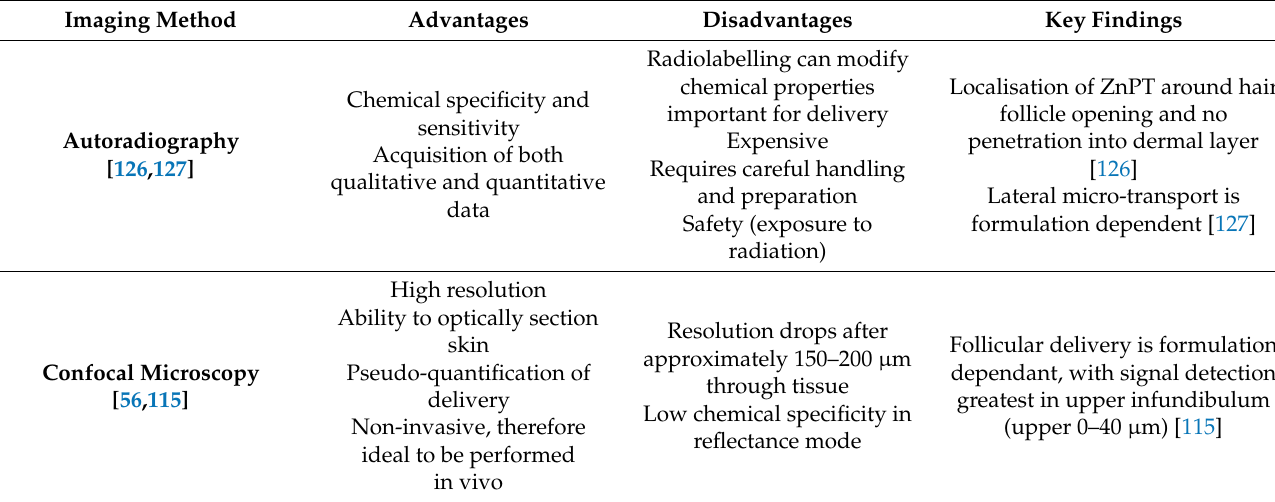
Table 1. Comparison of skin imaging methods for assessing zinc pyrithione topical delivery. Imaging Method Key